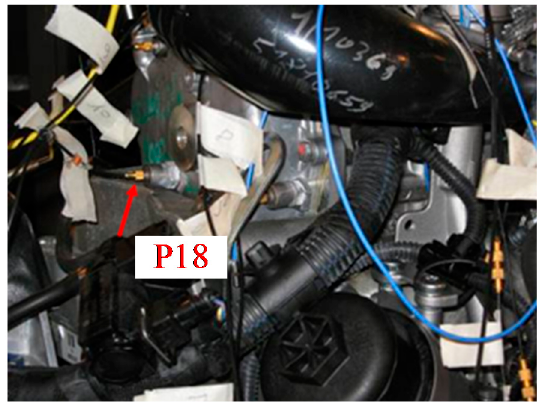
Figure 4. Accelerometer placed on the chain cover.